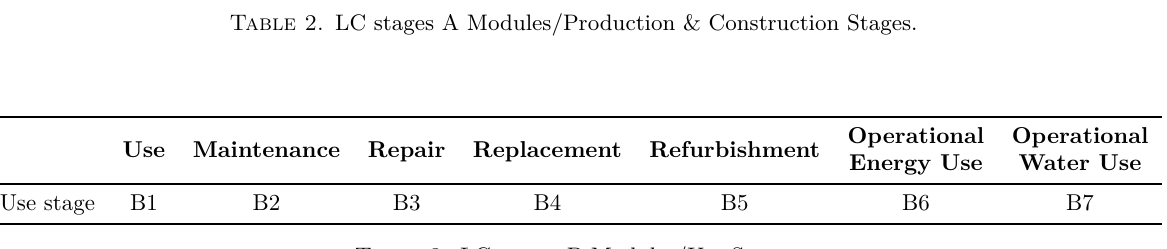
Table 3. LC stages B Modules/Use Stage.